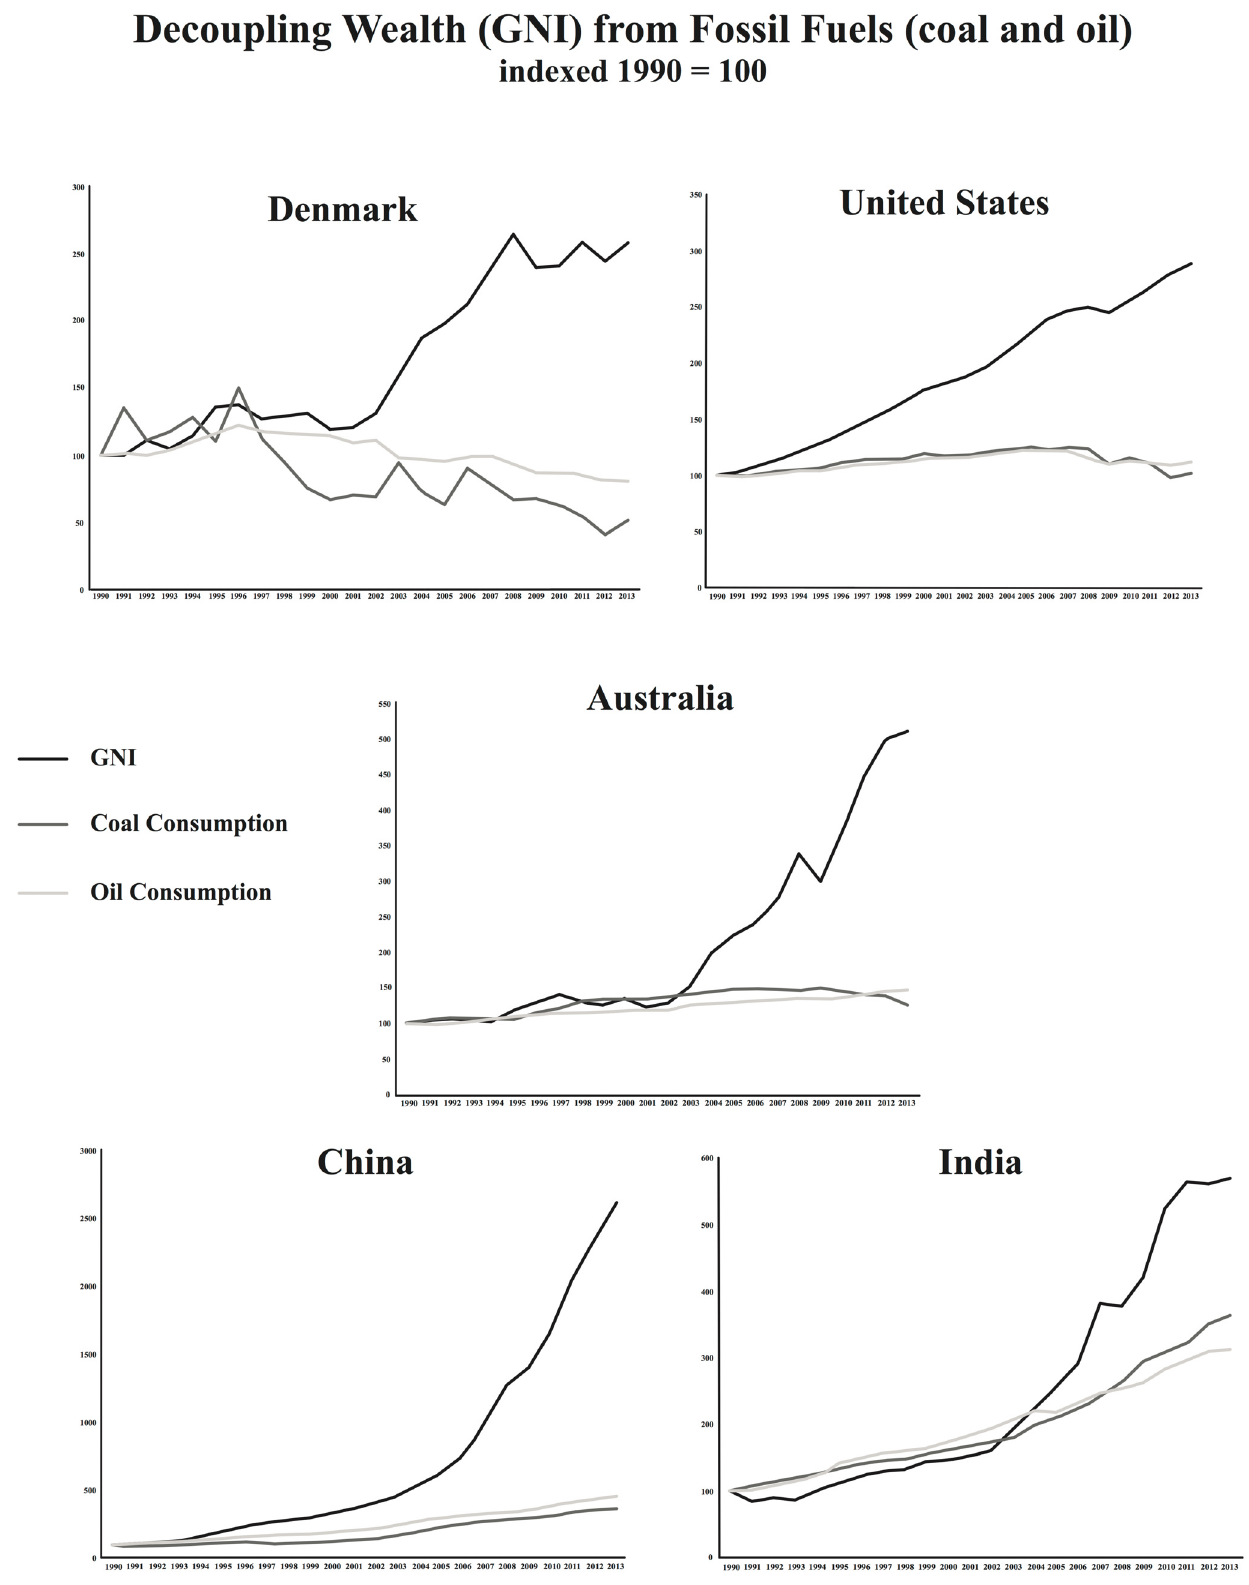
Fig. 1. The decoupling of economic growth and fossil fuel consumption in Denmark, America, Australia, China and India. GNI is Gross National Income, similar to GDP Gross National Product. Source : Authors own graphic based on data sourced from the WBG [8] and the EIA